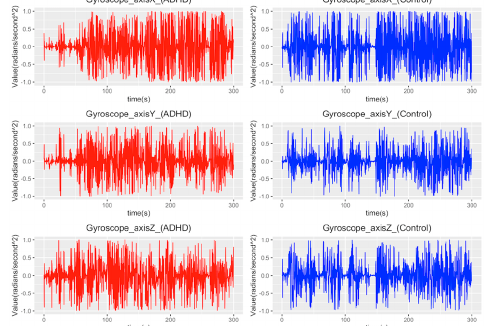
Figure 2. An example of one patient’s and one control’s variance in the gyroscope measurements in the three axes. Data showed higher variance values of the gyroscope measurements in the x -, y -, and z -axes in a child with attention-deficit hyperactivity disorder (ADHD) than in the matched control. Table 2. Comparison of the gyroscope measurements between the attention-deficit hyperactivity disorder (ADHD) and control groups. ADHD